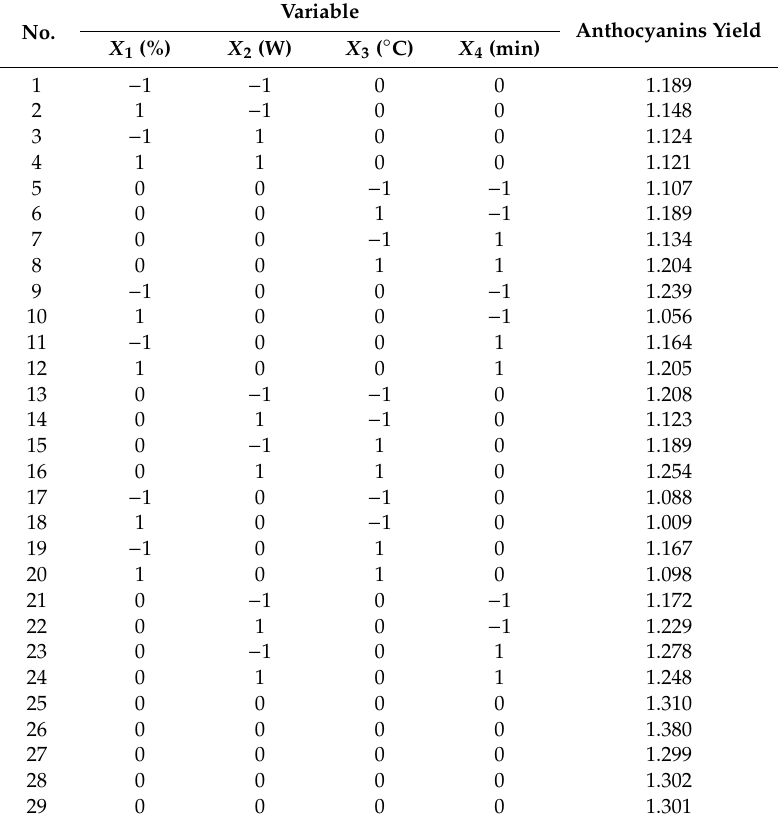
Table 3. Experimental design and results of response surface methodology (RSM).